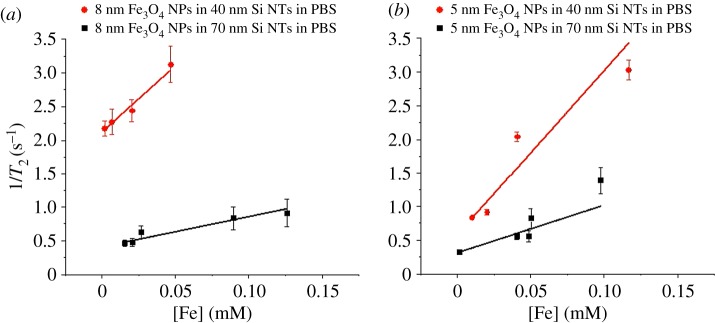
1/T2 versus [Fe] of Si NTs loaded with: (a) 8 nm Fe3O4 NPs and (b) 5 nm Fe3O4 NPs.